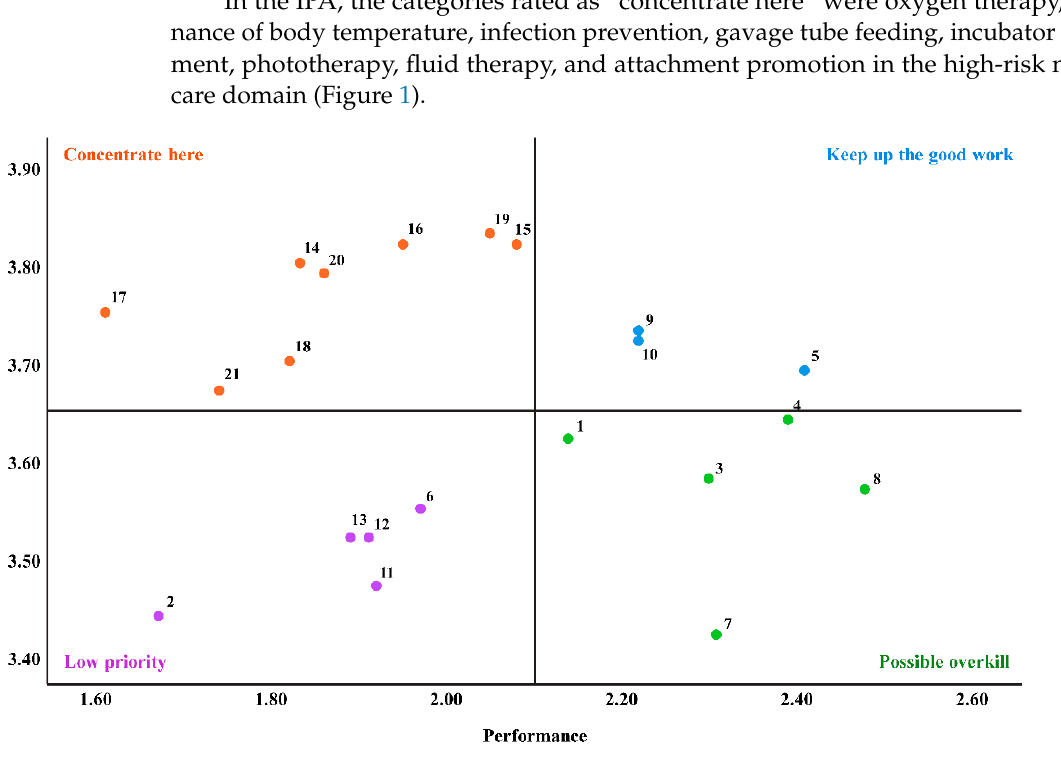
Table 4. Differences in the needs for handover training according to the presence or absence of ne- onatal nursing clinical field practice ( n = 132).